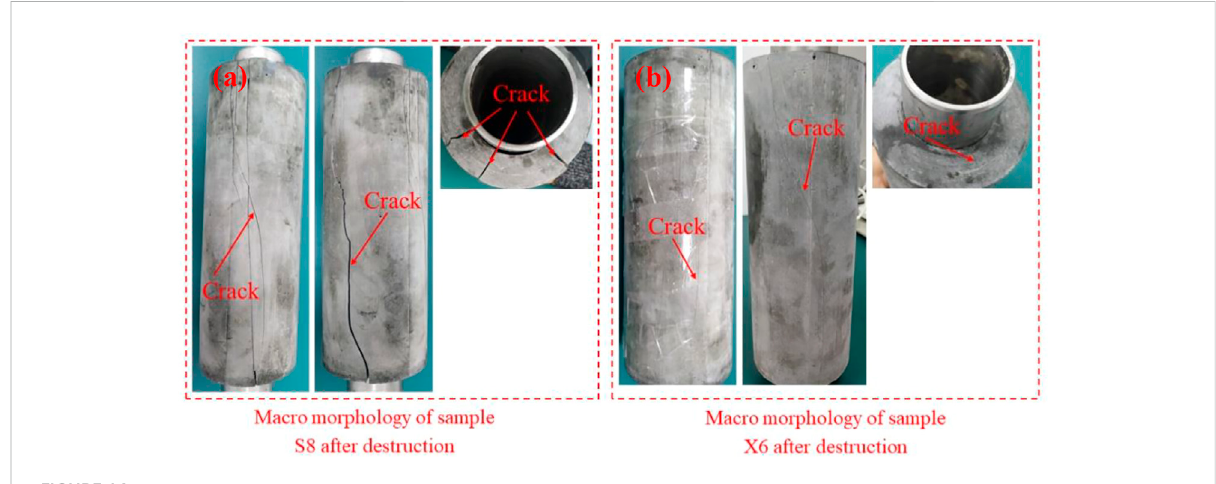
FIGURE 14 Macromorphology of cement sheath after cracking.